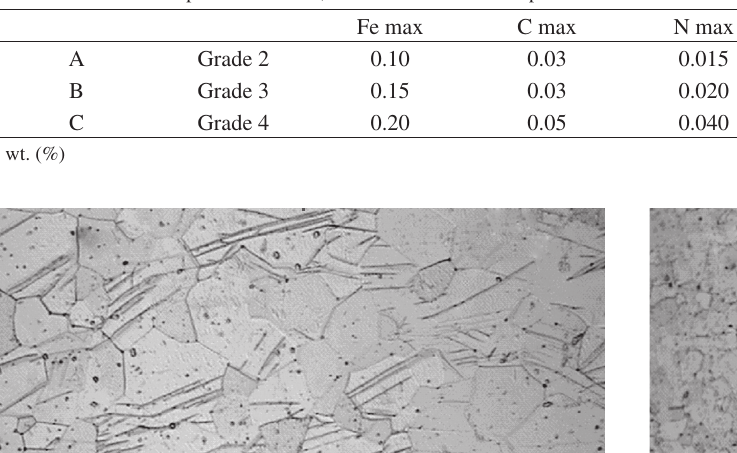
Table 1. Chemical composition of the A, B and C CP-Ti dental implants.